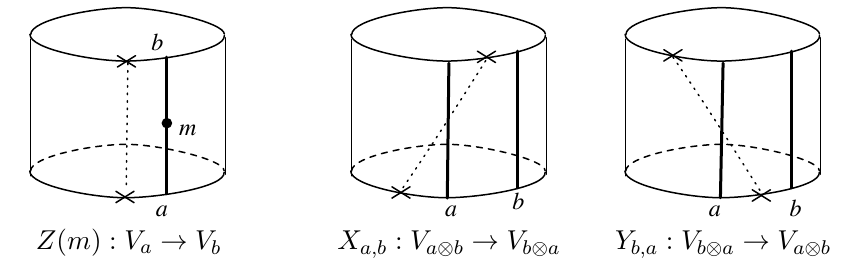
Figure 34 . Basic operations on the